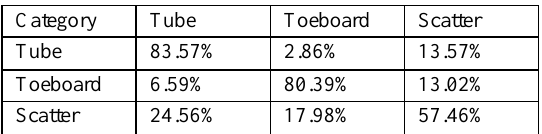
Table 2. Confusion matrix of synthetic point cloud result with noise level of 30%.